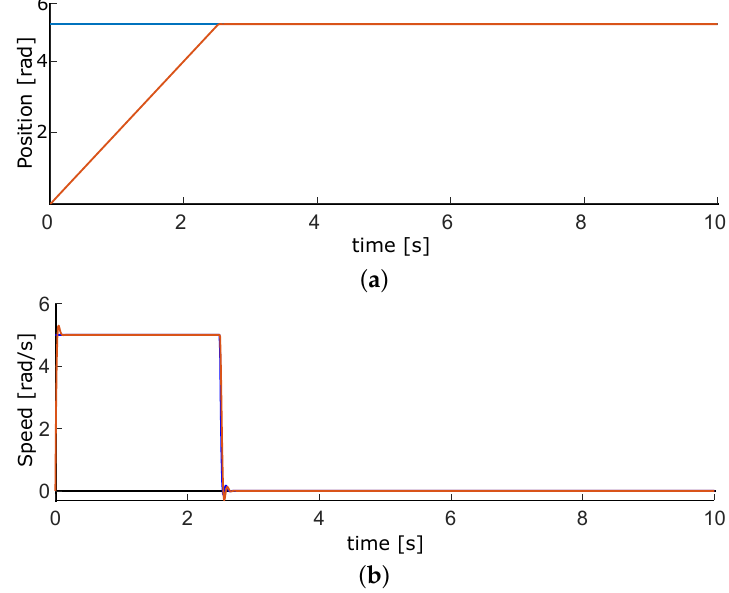
Figure 17. Simulated results for position and velocity control of DC motors where the blue lines are the setpoint and red ones the control signals. ( a ) Position plot. ( b ) Velocity plot.